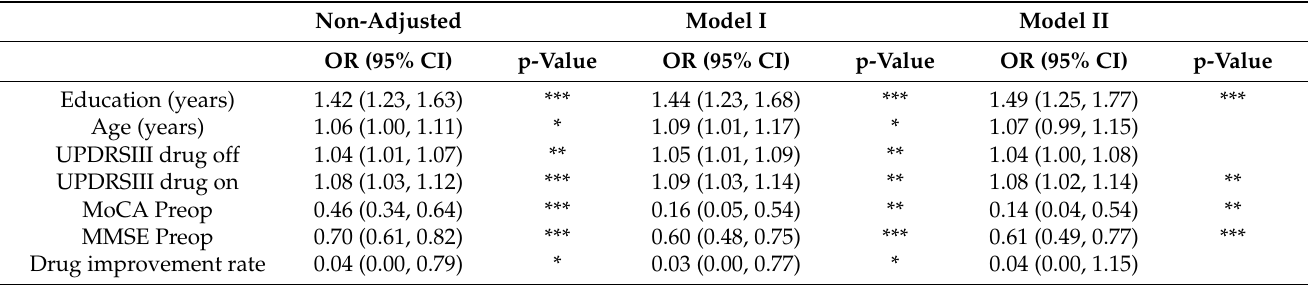
Table 3. Multivariate regression showing the effect of education, age, UPDRSIII drug off, UPDRSIII drug on, MoCA Preop, MMSE Preop and drug improvement rate on the improvement rate of cognitive state.